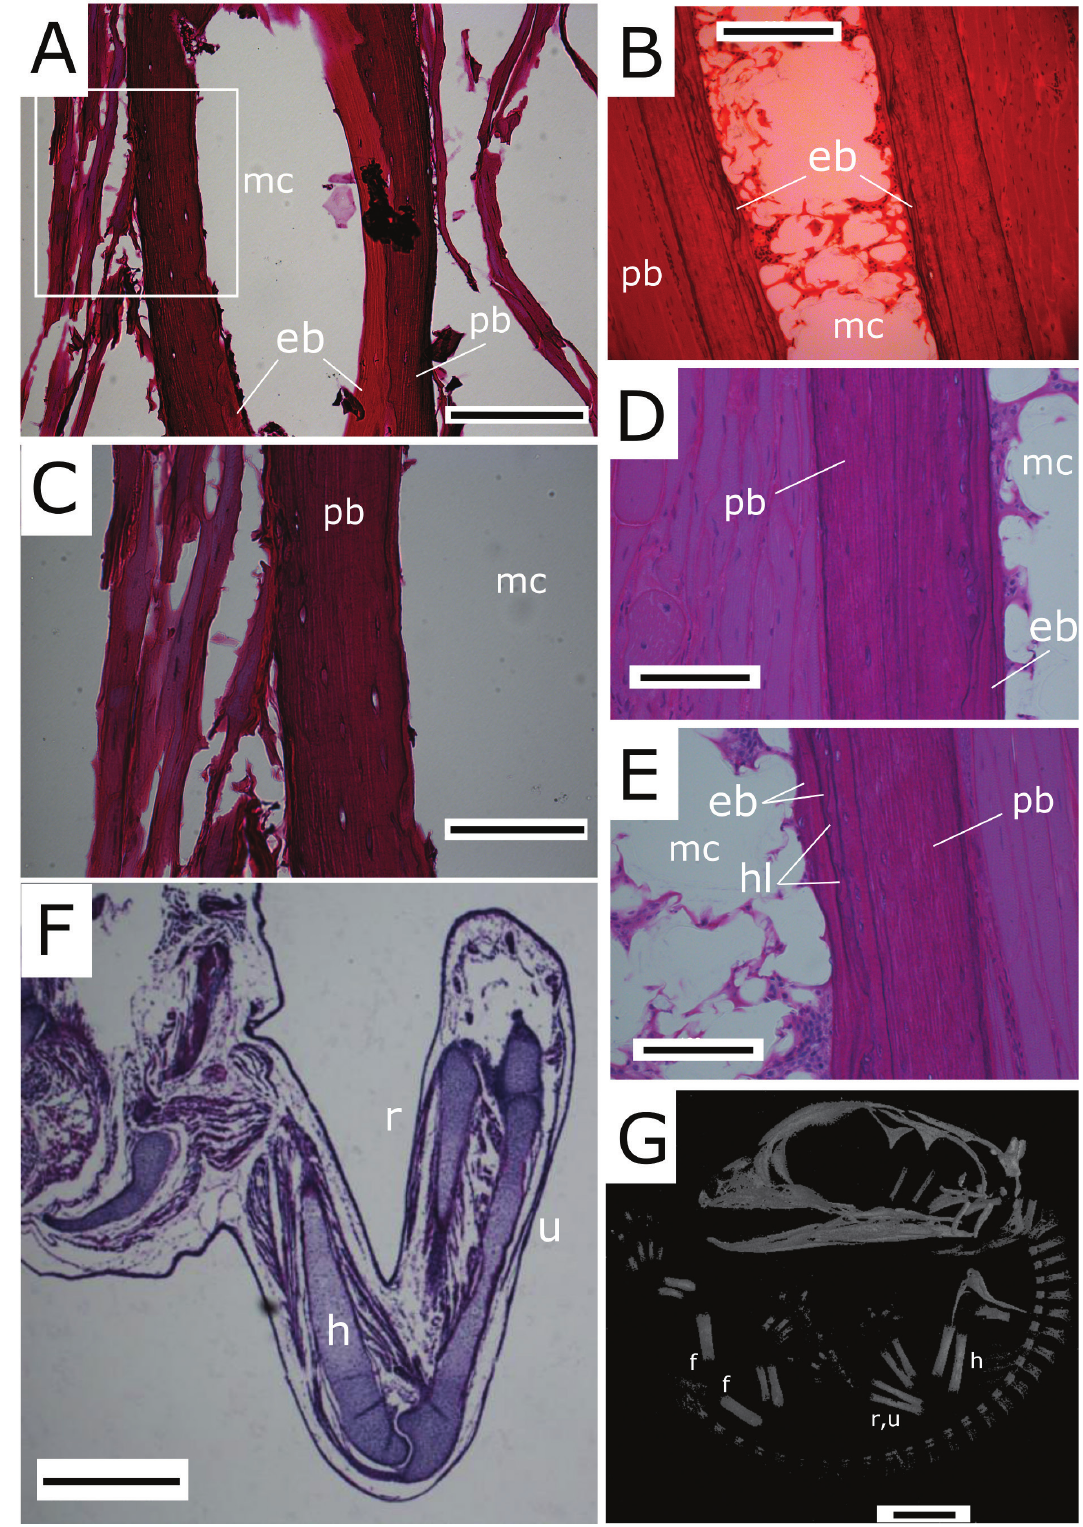
Figure 6. Bone histology of Hemidactylus long bones. Adult specimen CA2017_001 (cross section no. H63_FR_B5; A, C ), ZMB 87078 (cross section no. A12_FL_6b, one year old, SVL 47 mm; B, D, E ), and developmental stage I specimen CA2017_015 (F) and CA2017_014 (G) . (A–E) Longitudinal sections (HE staining) of the humeral shaft showing a clear pattern of alternating bone lamellae in the periosteal cortex and remodeling in the endosteal region. (C) Close-up of boxed area in (A) . (D, E) Magnification of cortical bone of similar areas in (B) . (F, G) Onset of ossification in individuals, 25 days before hatching, as seen in histological sections (F) and µ CT scans (G) . Abbreviations: eb – endosteal bone; f – femur; h – humerus; hl – Howship lacunae; mc – medullary cavity; pb – periosteal bone; r – radius; u – ulna. Scale bars in (A, B) equal 200 µ m, in (C–E) 100 µ m, in (F) 500 µ m, and 1 mm in (G)